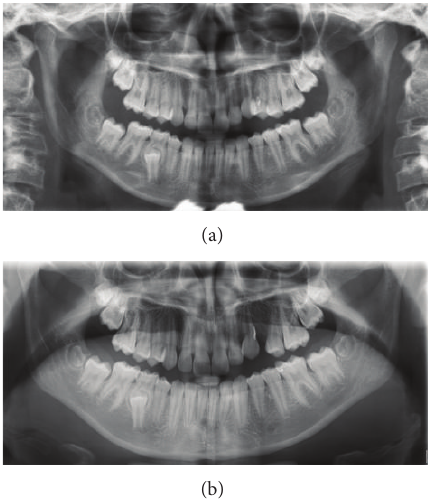
Figure 1: (a) The first panoramic image shows an osteolytic area on the marginal bone border between 22 and 24. There is a deep vertical bone lesion on the mesial side of 24. It is challenging to see resorption on the coronal part of the roots. (b) Panoramic image three months after the extraction of 24. The healing of the extraction region is in progress. In the region 22-23, the osteolytic area has remained the same compared to the earlier